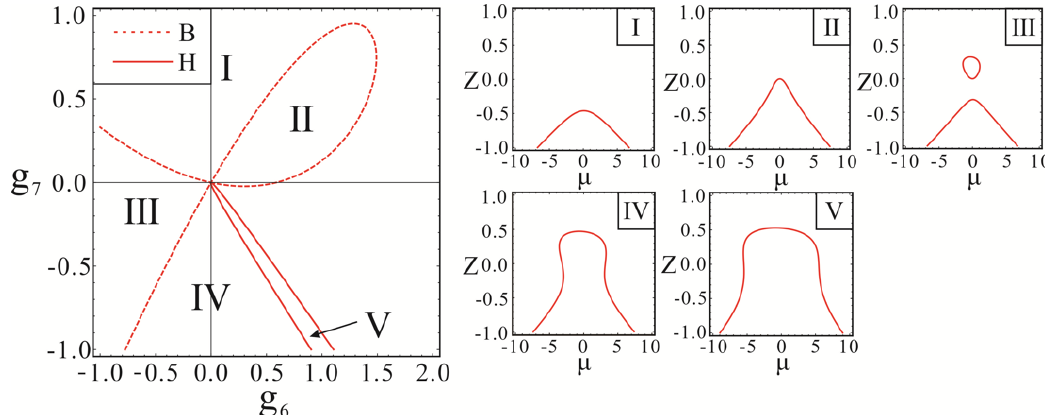
Figure 9. The transition sets and bifurcation diagrams on the g 6 – g 7 plane.